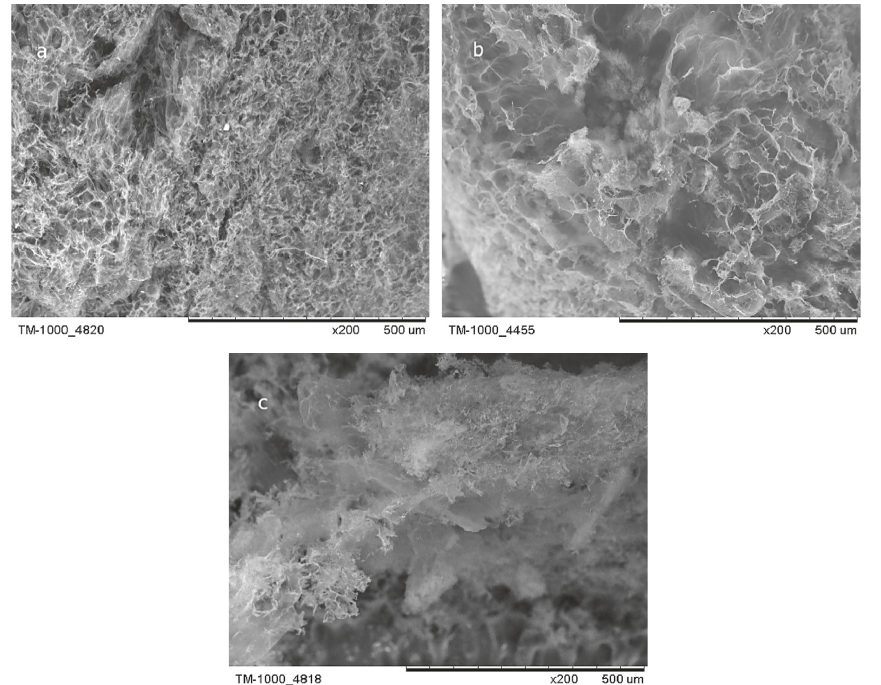
Figure 5: SEM images of CMC/CS hydrogel at different ratios: (a) 200, (b) 75, and (c)